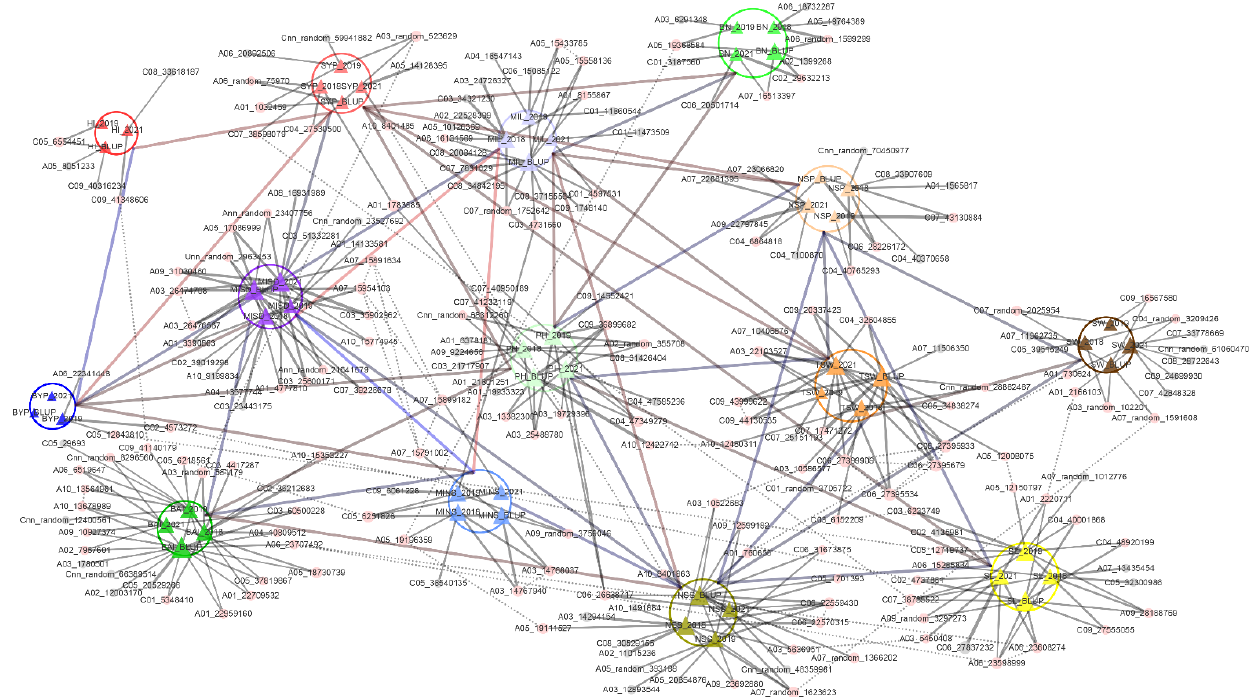
Figure 5. Phenotype-SNP network for 14 traits in rapeseed. Traits are solid triangles and SNPs are solid circles. Different traits are displayed in different colors. The links represent the significant correlations among them and the colors that vary from blue to red represent the partial correlation coefficients. SNPs associated to more than one trait or environment or adjacent to other significant SNPs are in pink. SNPs with a physical distance of fewer than 200 KB are connected by dotted